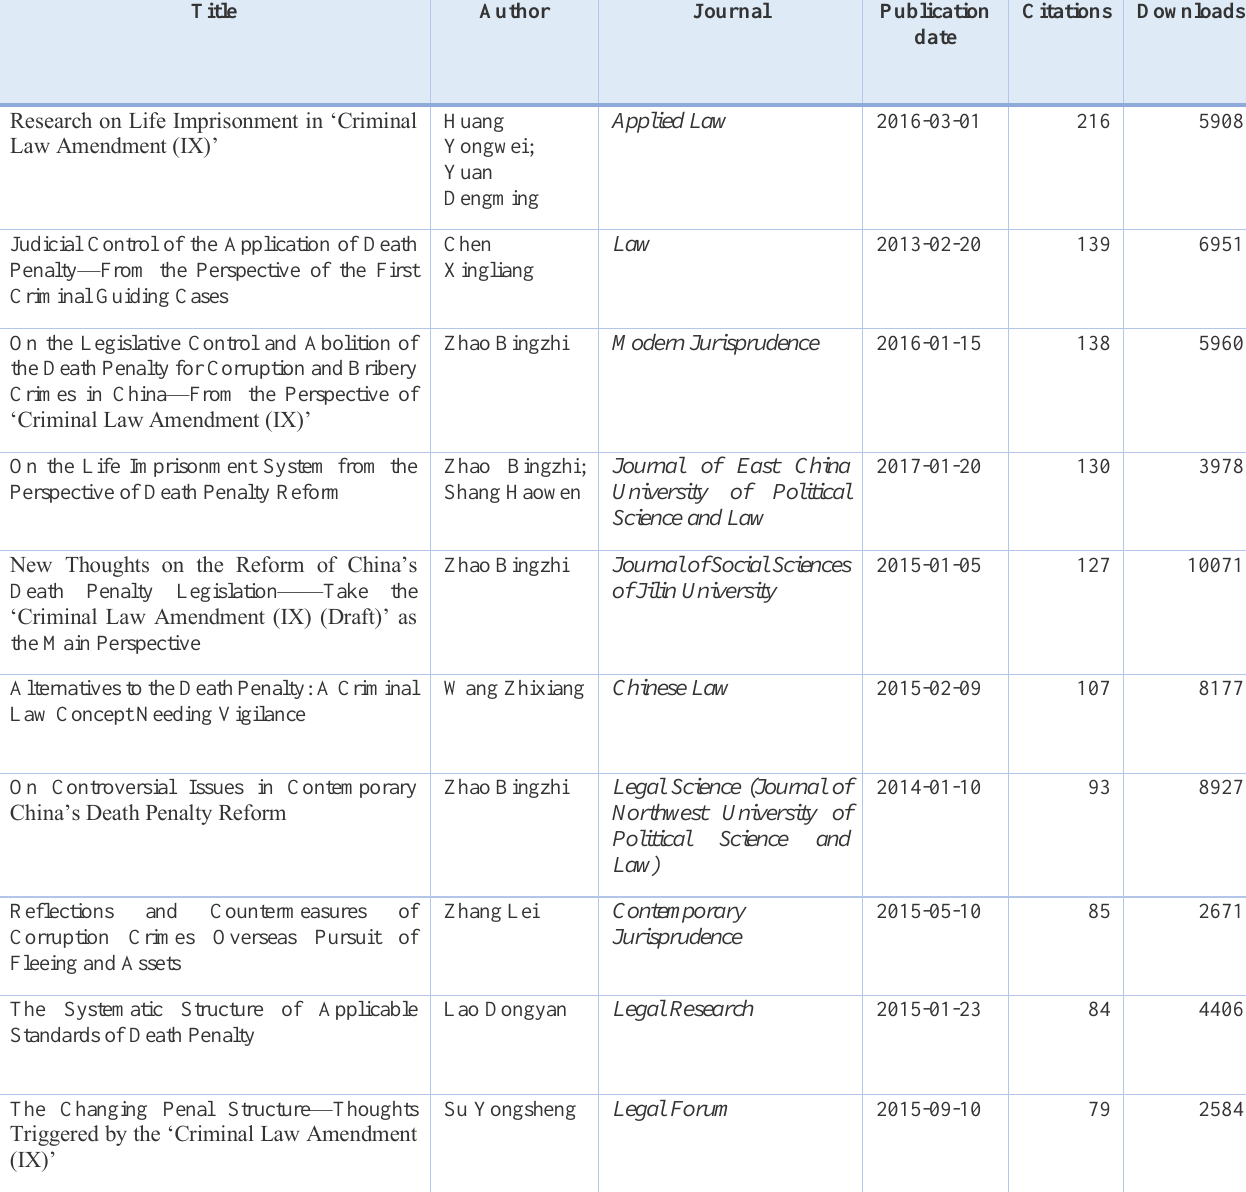
Table 1: Most cited Xi-era articles in China National Knowledge Infrastructure